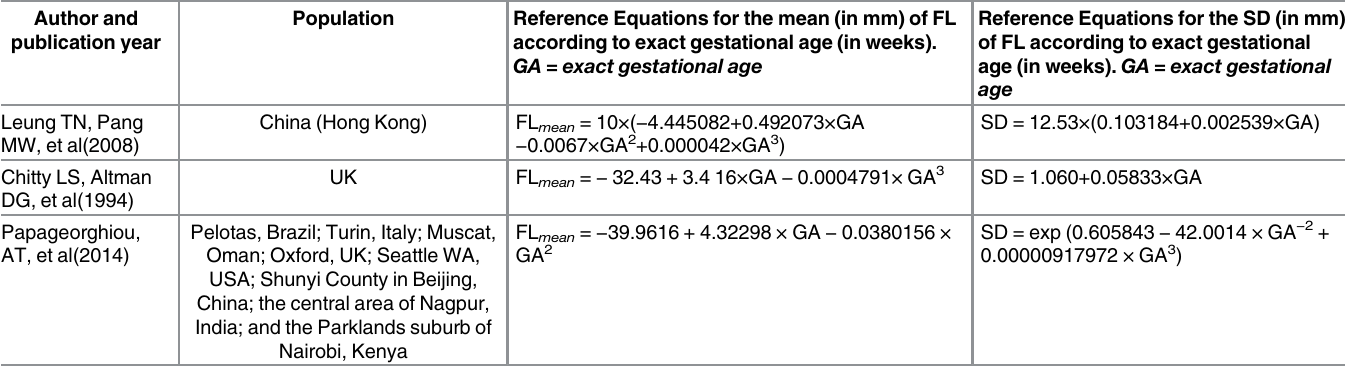
Table 1. Reference Equations for the mean and SD of